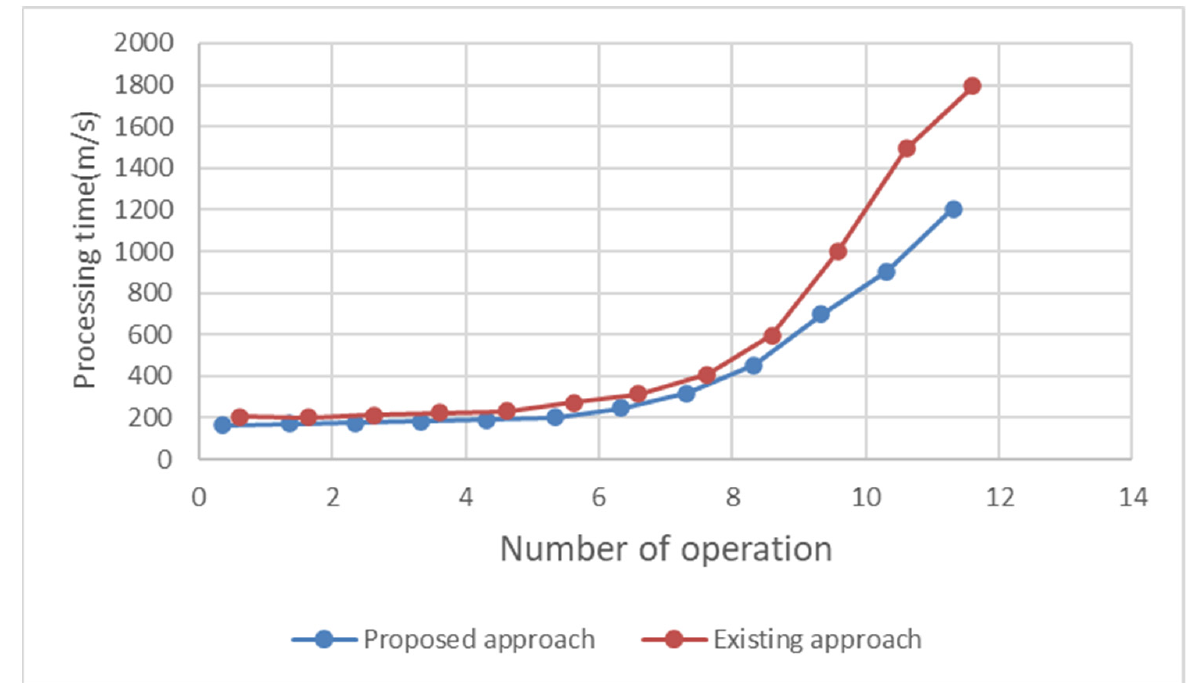
Figure 9. Packet drop scale in non-blockchain and blockchain-based techniques.